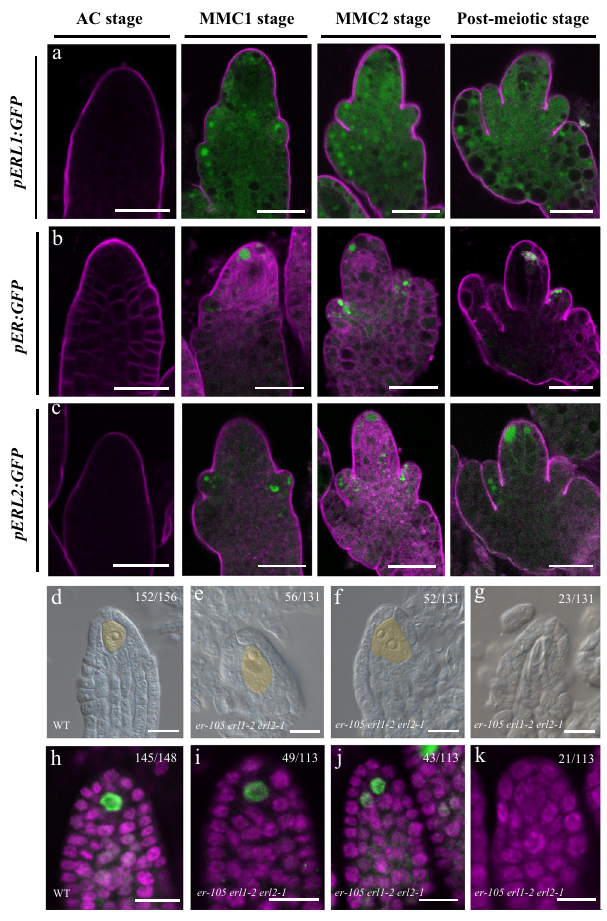
Fig. 9 Expression patterns of ERL1 , ER, and ERL2 in ovules and MMC speci fi cation phenotype in er-105 erl1-2 erl2-1 ovules. a , b GFP signals were detected in ovules at different stages from AC to the post-meiotic stages. Expression patterns of pERL1 : GFP ( a ); expression patterns of pER : GFP ( b ); expression patterns of pERL2 : GFP ( c ). The magenta signal corresponds to FM4-64 dye outlining the ovule. Scale bars,10 μ m. d – g DIC images of wild-type (WT) ( d ) and er-105 erl1-2 erl2-1 ( e – g ) ovules. Numbers denote the frequencies of the phenotypes shown. MMC is fake colored by yellow. Scale bar, 20 μ m. h – k AGO9 immunolocalization of WT ( h ) and er-105 erl1-2 erl2-1 ( i – k ) ovules. Green and magenta signals correspond to AGO9 localization and propidium iodide signal, respectively. Scale bars,10 μ